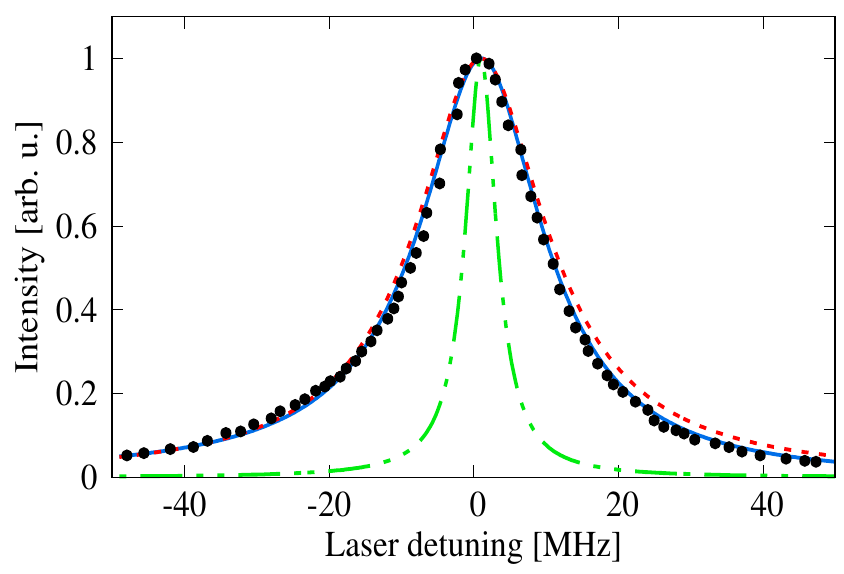
Figure 4. Theoretical (solid curve, Equation (19)) and experimental [11] (dots) absorption profile of the D 2-line of Cs upon an excitation of the closed F (cid:48)(cid:48) = 4 → F (cid:48) = 5 transition in a cold sub-thermal Cs beam for laser power of 1.0 mW (the corresponding Rabi frequency Ω = 21.2 MHz). The dashed curve corresponds to the power broadening profile. The bar-dashed curve exhibits the natural broadening profile.